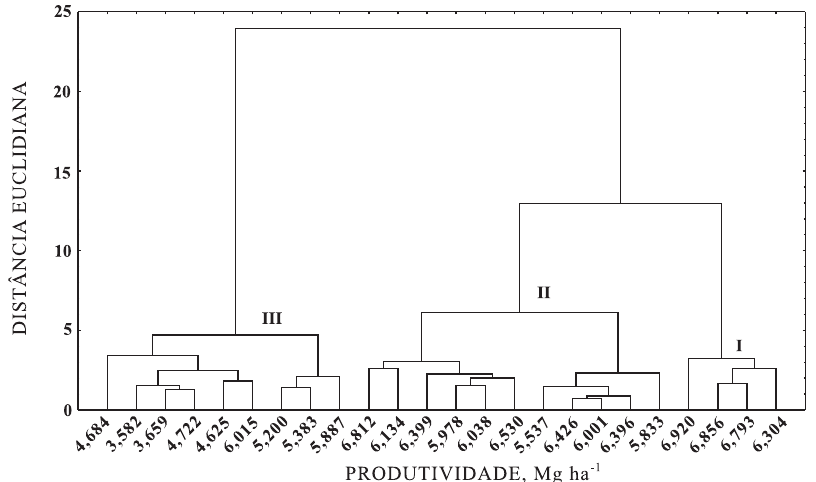
Figura 1. Dendrograma resultante da análise hierárquica de agrupamentos mostrando a formação de grupos segundo a densidade radicular, superfície radicular, diâmetro radicular, matéria seca das raízes, altura das plantas, altura de inserção da primeira espiga, diâmetro do colmo, matéria seca das plantas e densidade do solo.